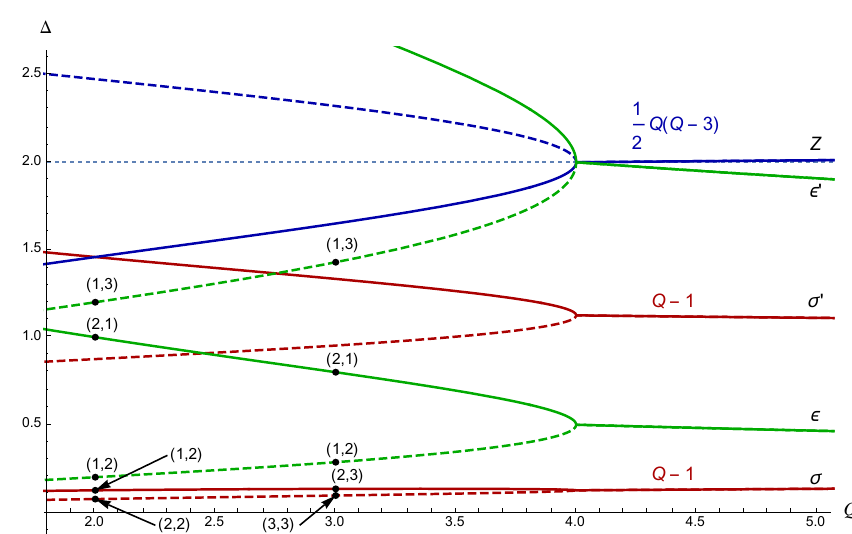
Figure 7: Dimensions of light scalar operators as functions of Q . The Q (cid:54) 4 region corresponds to the critical (solid) and tricritical (dashed) Potts models. Singlet operators are in green, other multiplicities are marked. ∆ = 2 is the marginality line. The ( r , s ) positions in the Kac table are shown for (cid:34) , (cid:34) (cid:48) , as well as for σ which is degenerate for Q = 2,3. Notice that (cid:34) and (cid:34) (cid:48) remain Kac-degenerate with the same integer ( r , s ) also for non-integer Q , while this is not true for the other shown operators. For Q > 4 we show the real parts of the analytically continued dimensions, see section